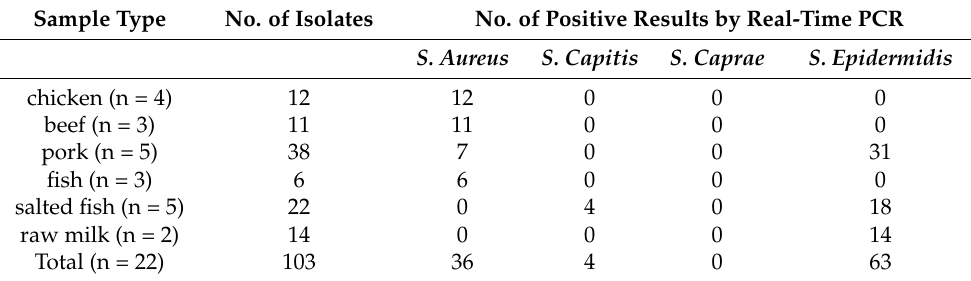
Table 3. Identification of strains isolated from food samples.